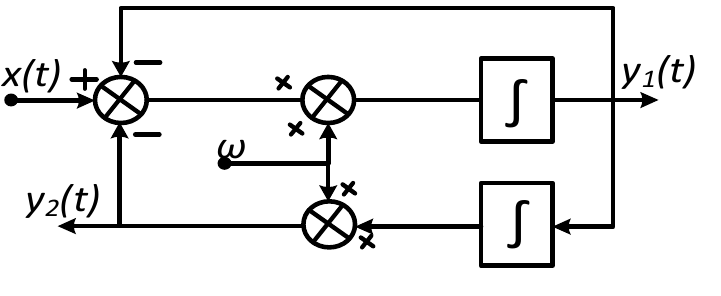
Figure 7. Control layout of SOGI .